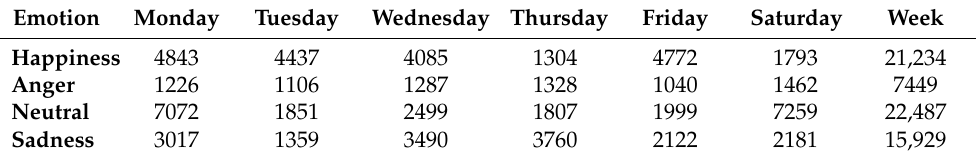
4. Discussion Cognitive ergonomics is focused on the prevention of "human failures," e.g., when an accident occurs and expert studies fail to detect any mechanical failure or physiological cause which can